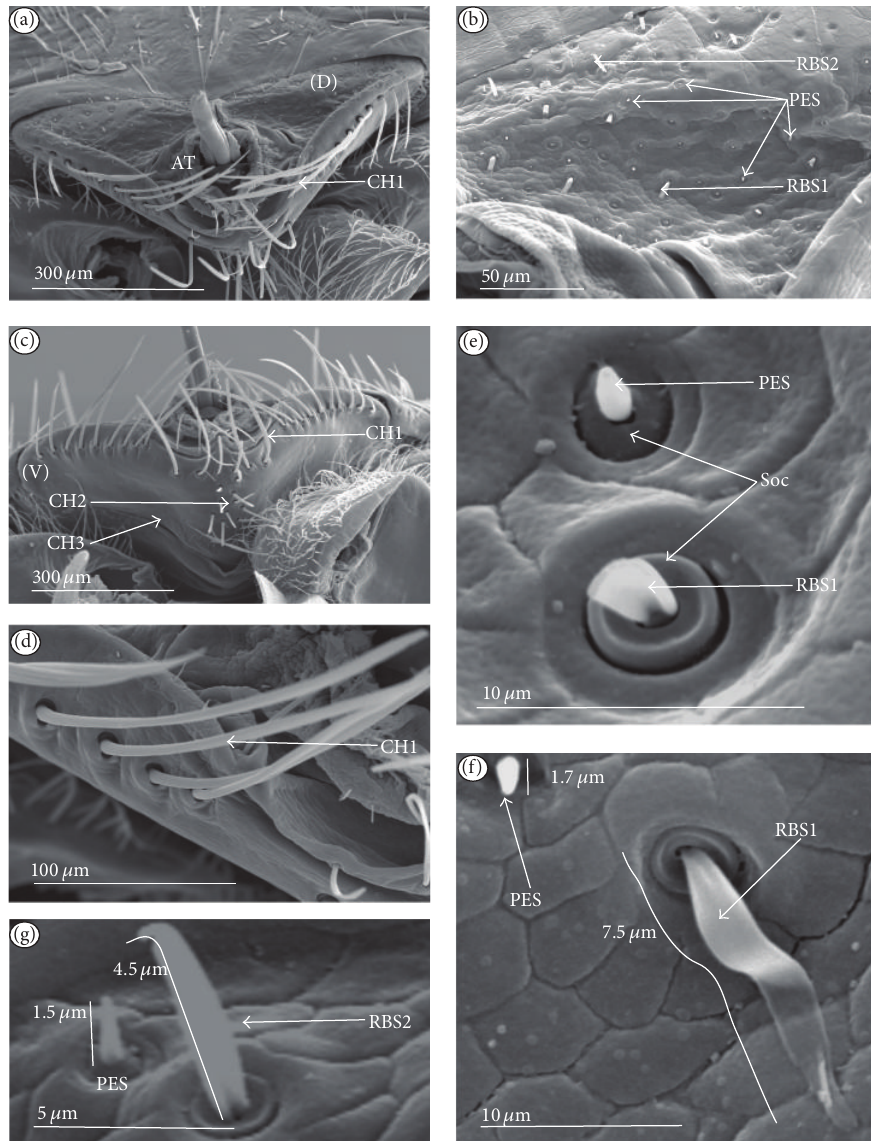
Figure 30: Types and size of the sensilla of the Corixidae: Cymatiinae ( Cymatia coleoptrata ). (a) Several of the CH1 are placed on the lateral edge of the labium and below the apex; several PES and RBS2 are visible on AT. (b) RBS1, RBS2, and PES are spread unevenly on the dorsal surface of the labium. (c) CH1, CH2, and CH3 are less numerous and situated ventrally. (d) CH1 magnified (lateral view). (e) PES and RBS1 magnified, Soc: socket. (f) RBS1, magnified. (g) The sizes of PES and